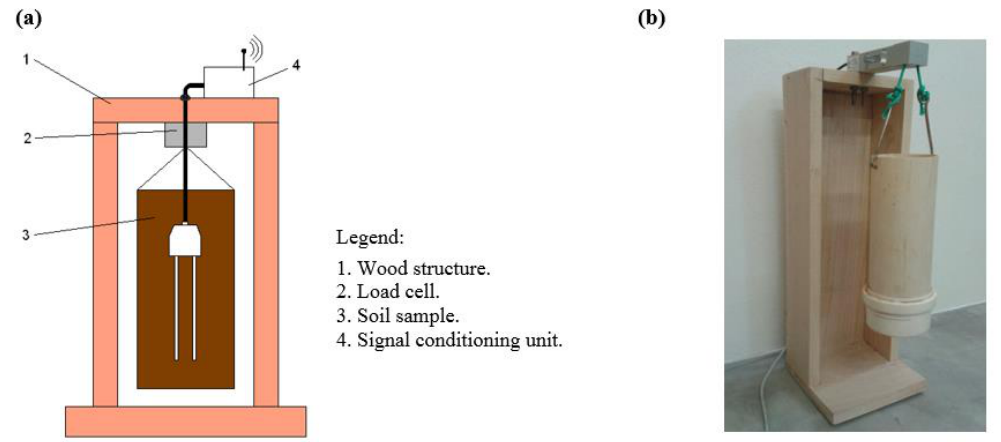
Figure 4. ( a ) Scheme support structure of the soil samples; ( b ) Structure of weighing the soil